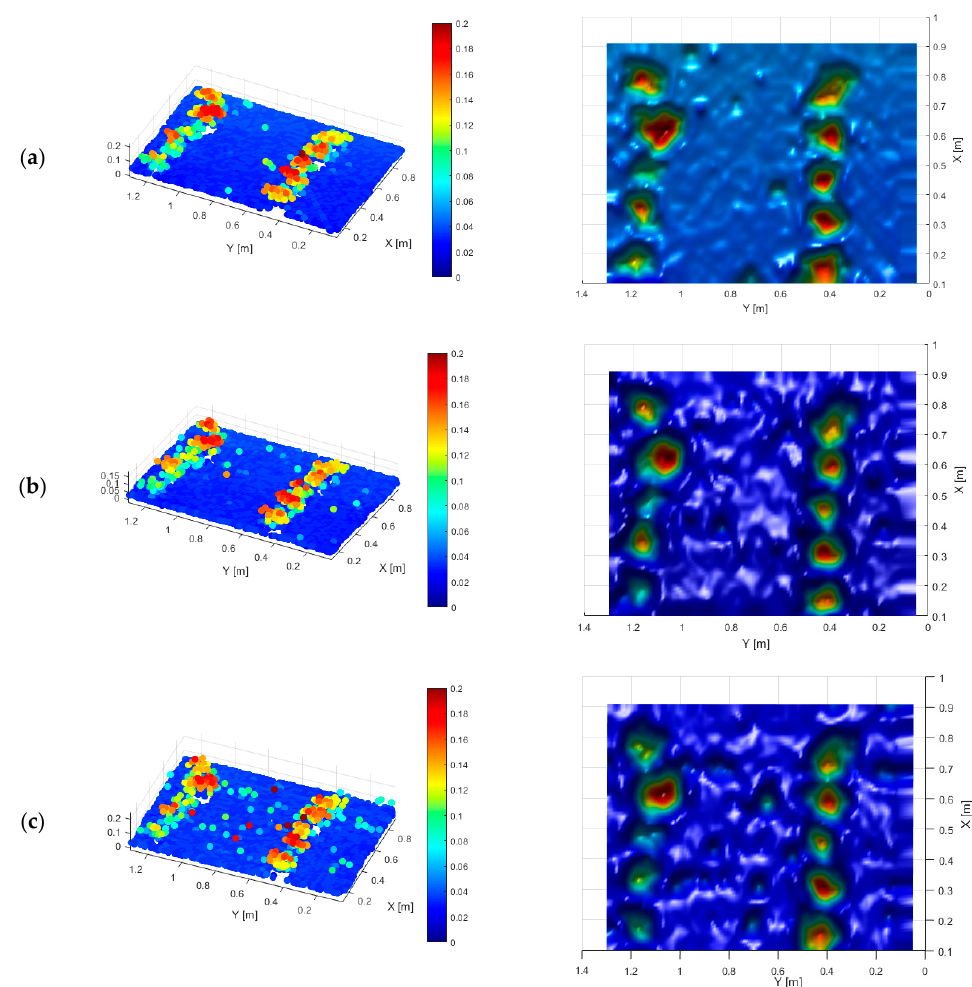
Figure 4. Visualization of the received 3D point clouds and surface reconstructions for the three scans ( a – c ). All readings are in m.